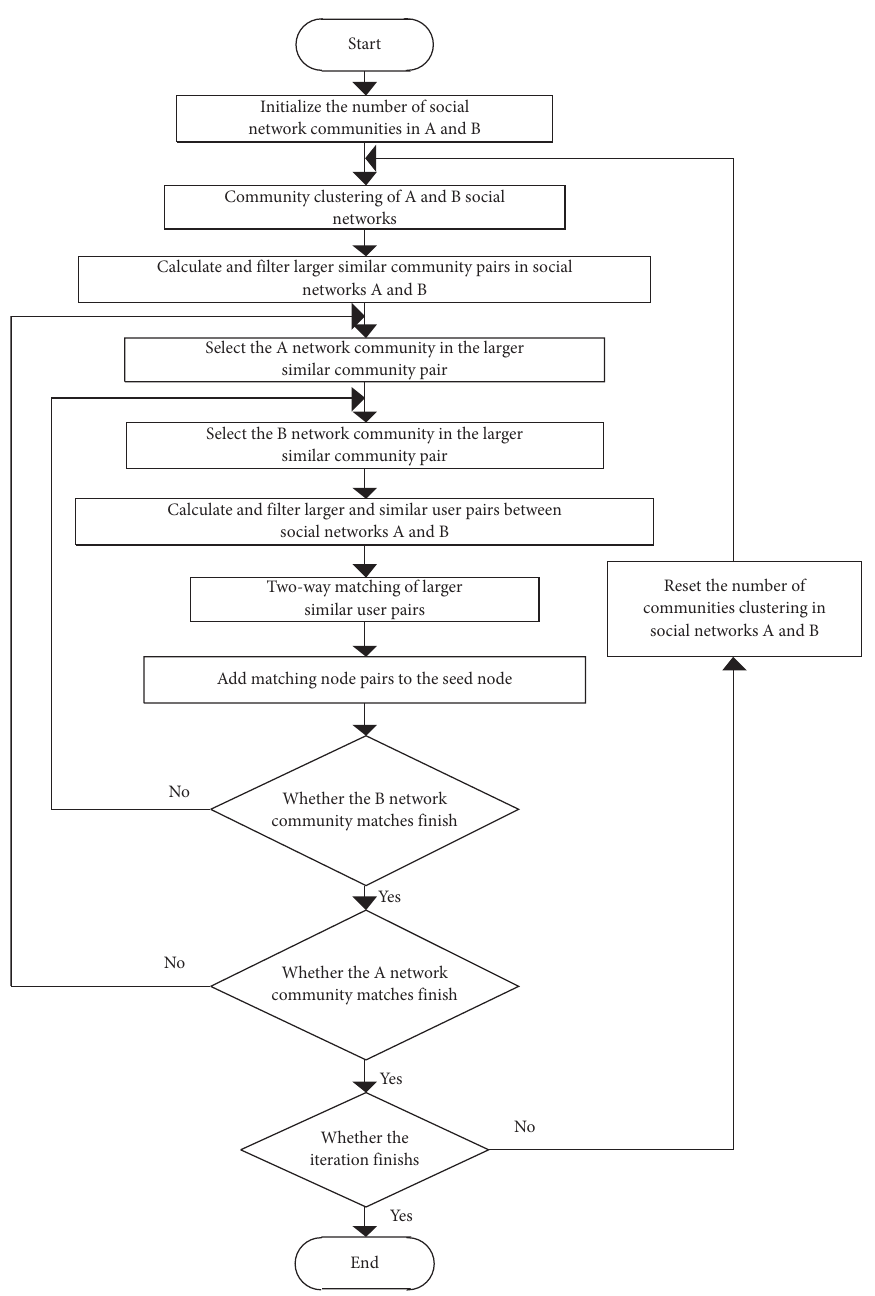
Figure 2: Flow chart of UIUTDC